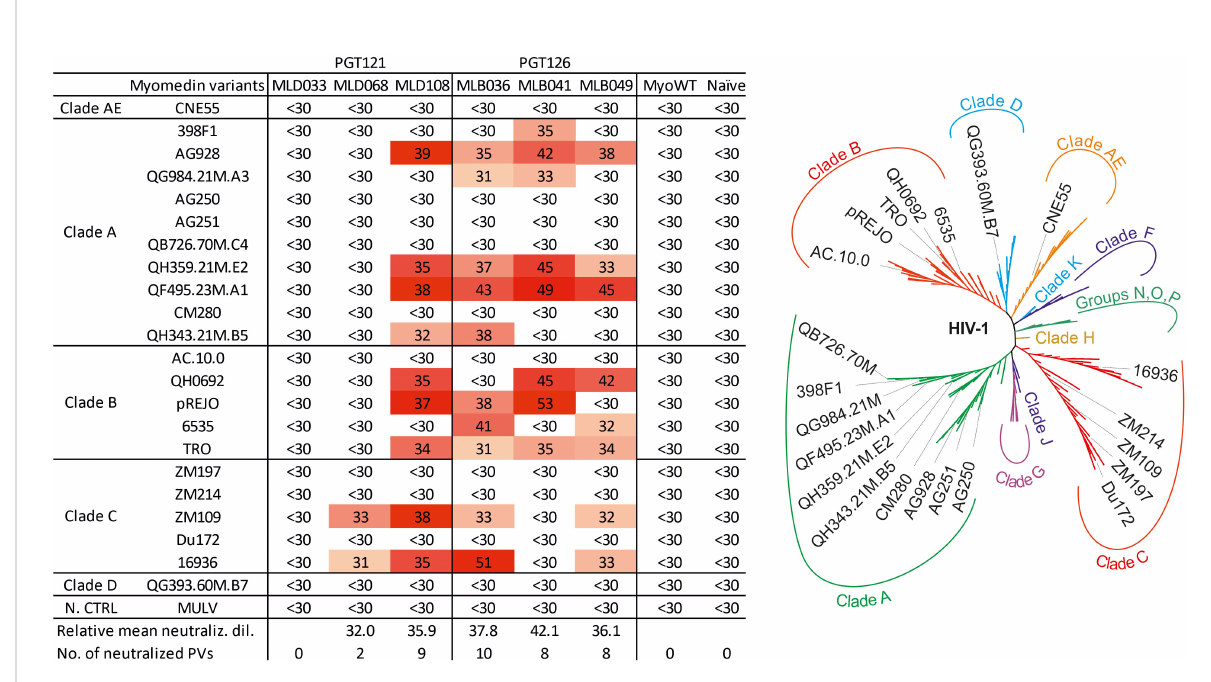
FIGURE 6 Neutralization pro fi le of MLD and MLB protein-stimulated hyperimmune mouse sera on the panel of HIV-1 pseudoviruses. Left: 50% virus neutralization reached by reciprocal serum dilution shown by color-coded values. Relative mean neutralization dilution re fl ects the average values of measured titers of the used pseudoviruses. The sum of neutralized pseudoviruses per Myomedin variant-induced sera as the number of neutralized PVs is calculated at a reciprocal titer higher than 30. As a control of the neutralization assay, murine leukemia virus (MULV) was used. Right: The unrooted phylogenetic tree of the used HIV-1 pseudoviruses in this